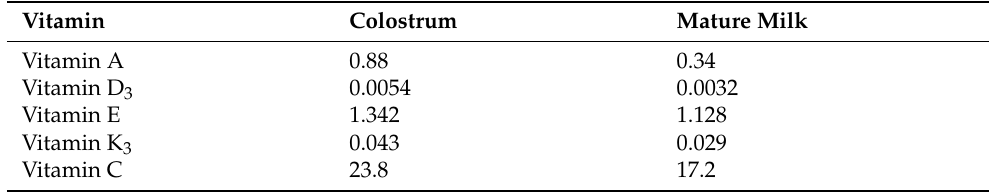
Table 8. Vitamins content in mare’s colostrum and mature milk